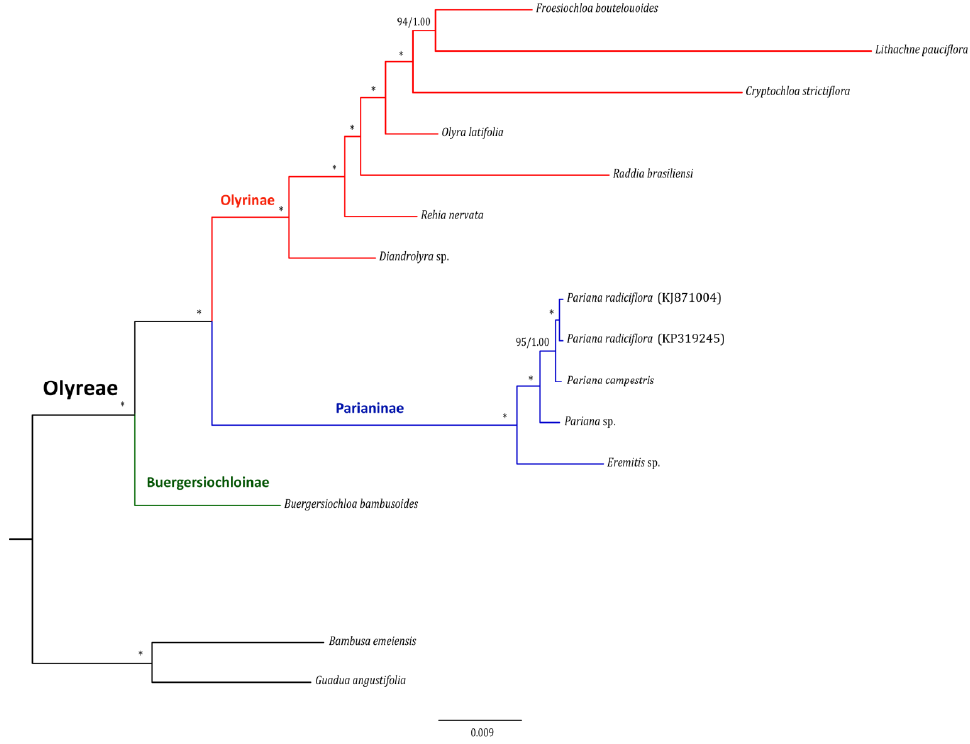
Figure 6. Congruent maximum likelihood (ML) and majority ‐ rule consensus Bayesian inference (BI) tree for Bambusoideae based on the complete plastome sequences of 67 grasses. Values above the branches represent maximum likelihood bootstrap (MLBS)/Bayesian inference posterior probability (PP). * indicates nodes with 100/1.00 support values. The positions of newly sequenced herbaceous bamboos ( Froesiochloa boutelouoides and Rehia nervata ) were shown in bold.